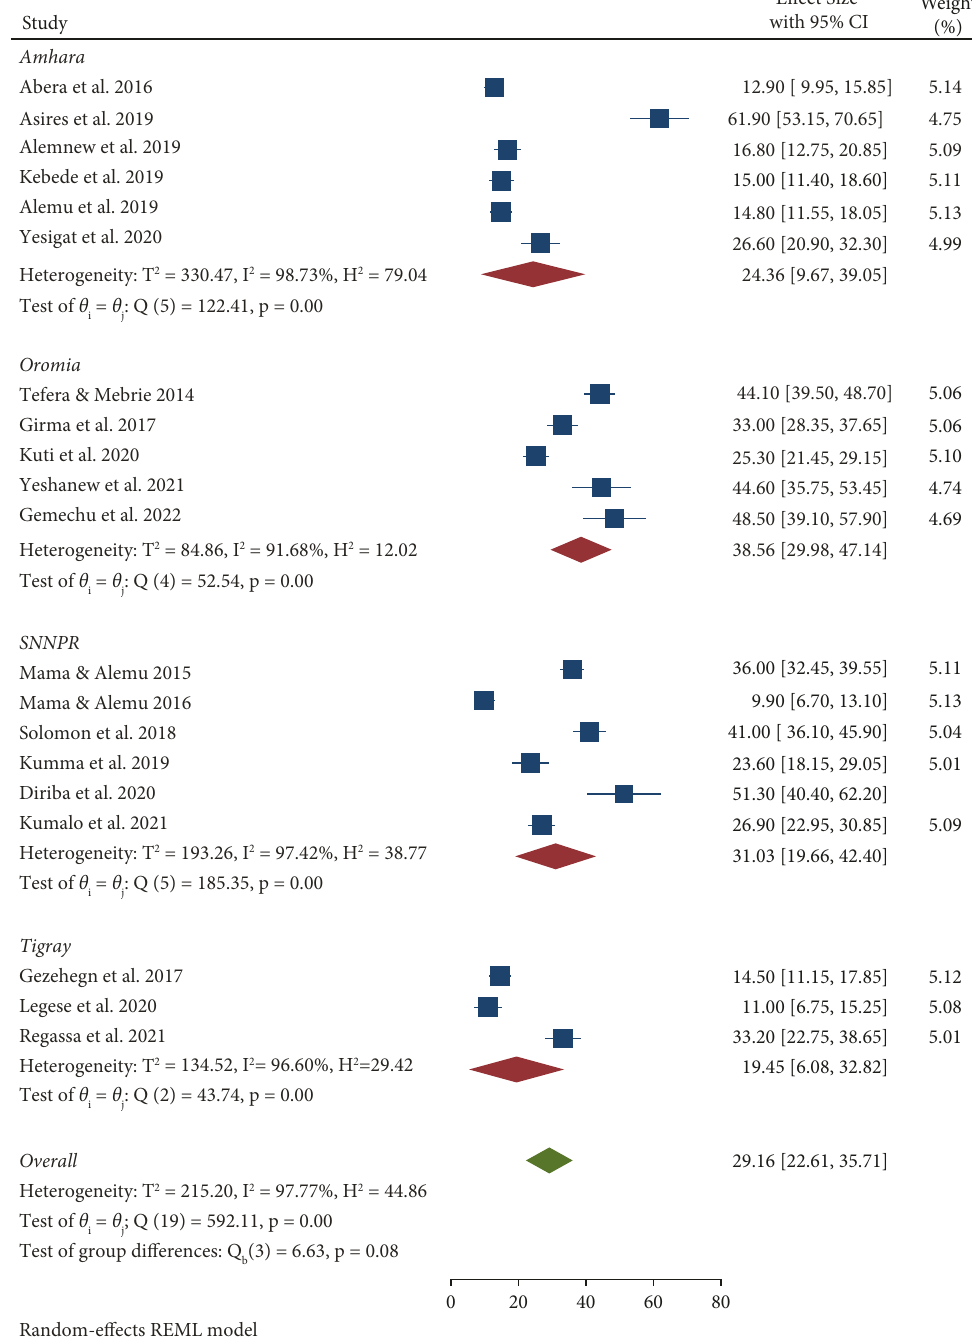
Figure 3: Pooled prevalence of IPs and EBIs among food handlers by